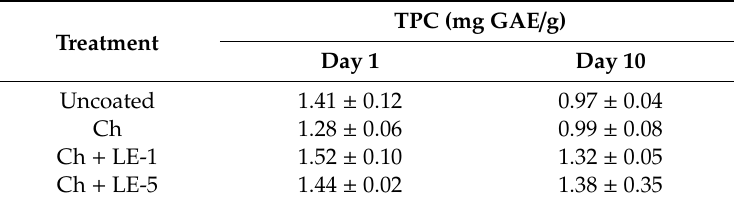
Table 6. Total phenolic compounds (TPC) of strawberries treated with di ff erent coatings. Ch = Chitosan; Ch + LE-1 = Chitosan + 1% of licorice extract; Ch + LE-5 = Chitosan + 5% of licorice extract.